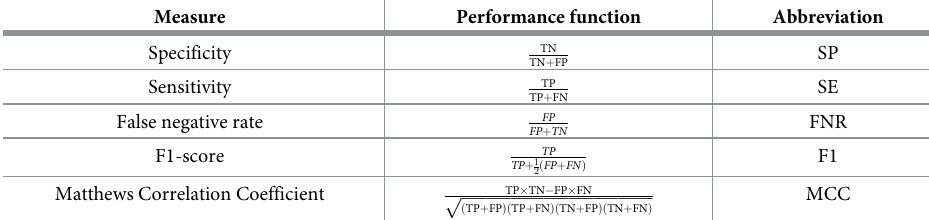
Table 4. Performance measures used to assess classification accuracy of the B-net and D-net graphical models